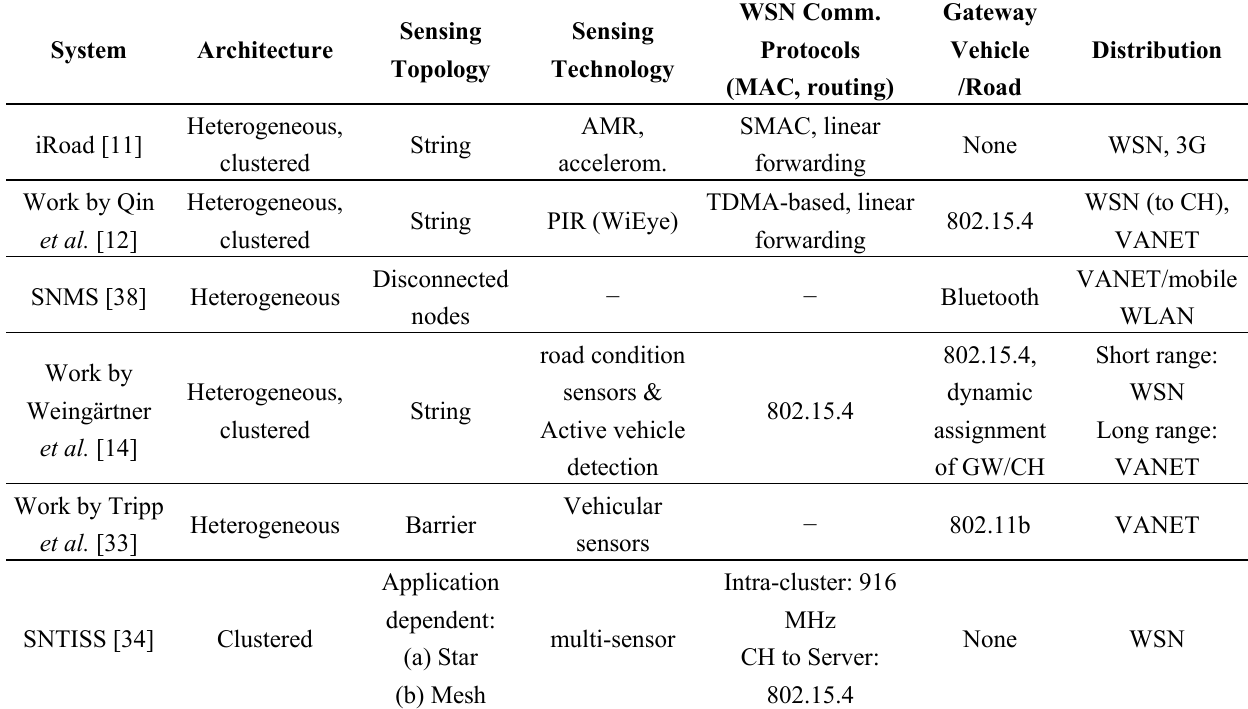
Table 3. Structural description of selected WSN-based ITS